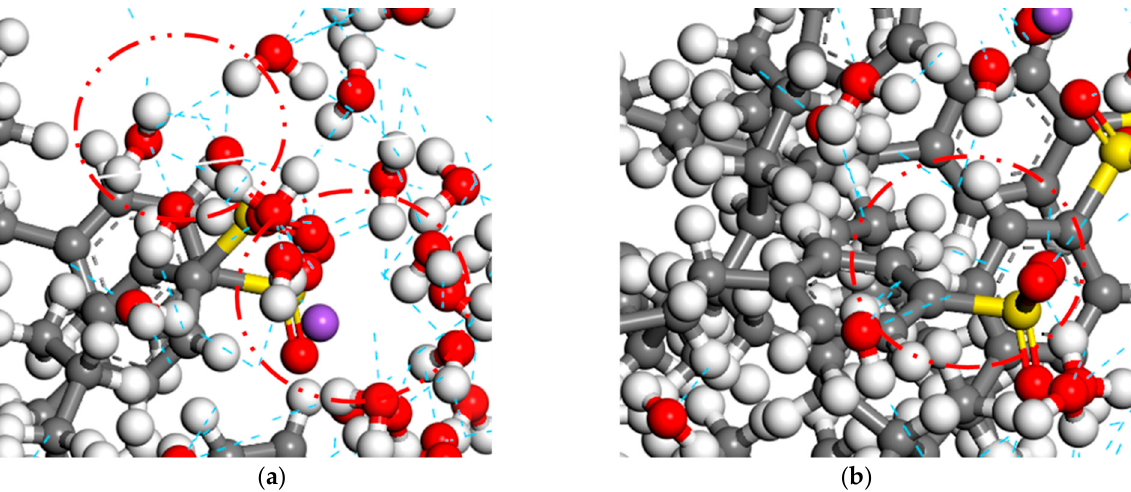
Figure 7. Hydrogen bonds between molecules of bio-oil asphalt/water emulsion. ( a ) Hydrogen bond between water and emulsifier. ( b ) Hydrogen bond between bio-oil asphalt and emulsifier.